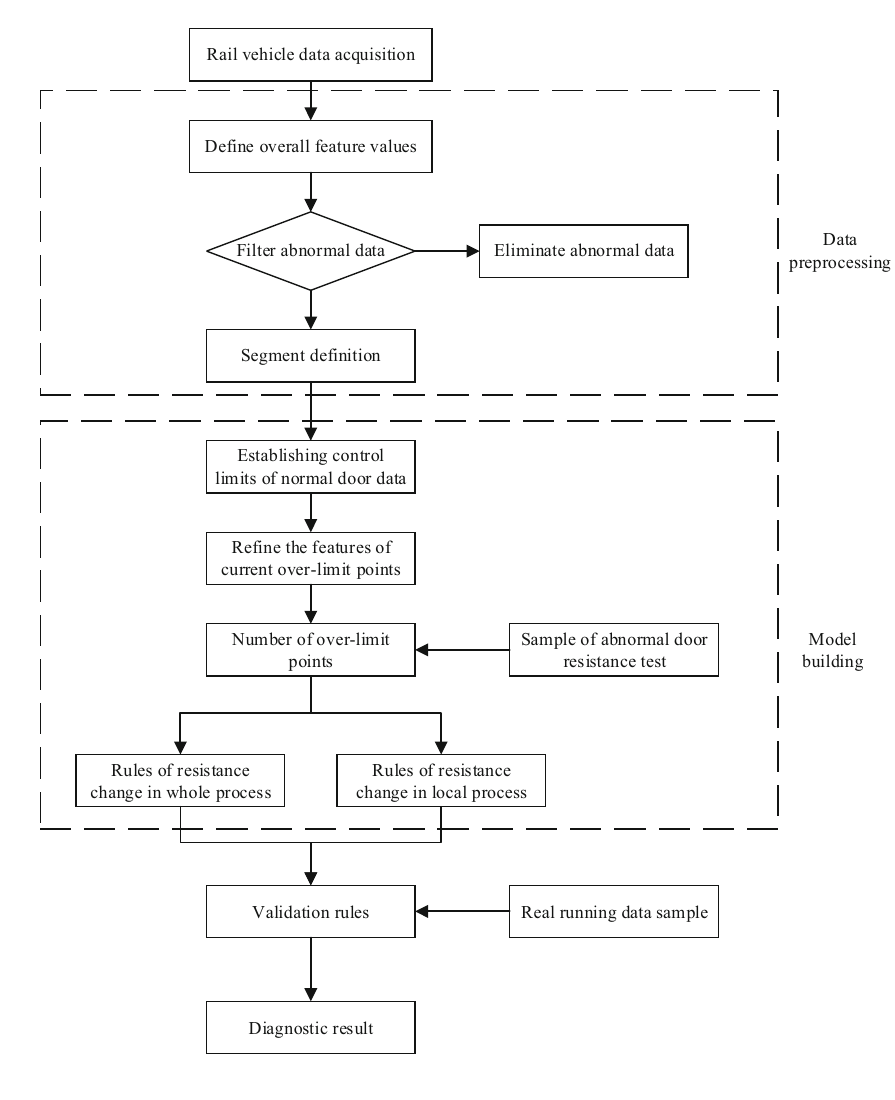
Fig. 2 Flowchart of rules making